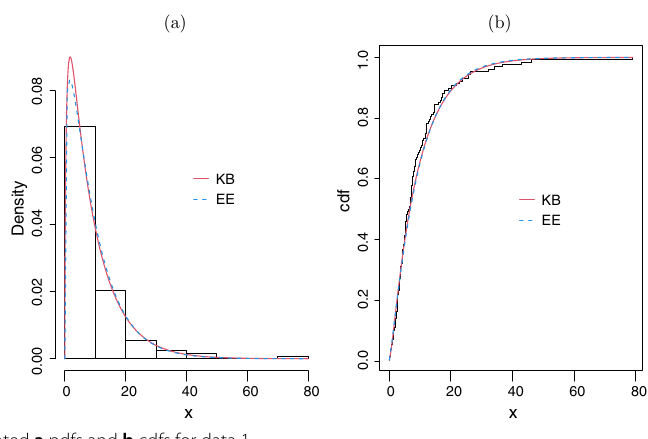
Fig. 2 Estimated a pdfs and b cdfs for data 1